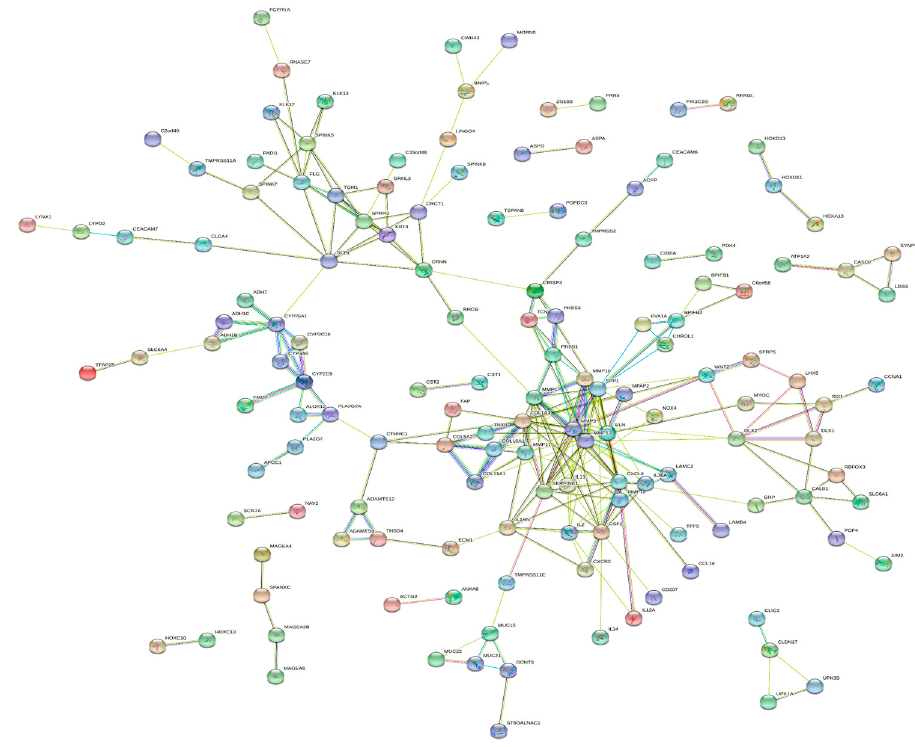
Figure 5. The PPI network analysis between different encoded proteins.